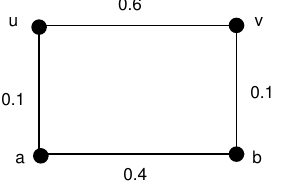
Figure 1. uv is an α -strong edge and WI ( G ) = WI ( G − uv )